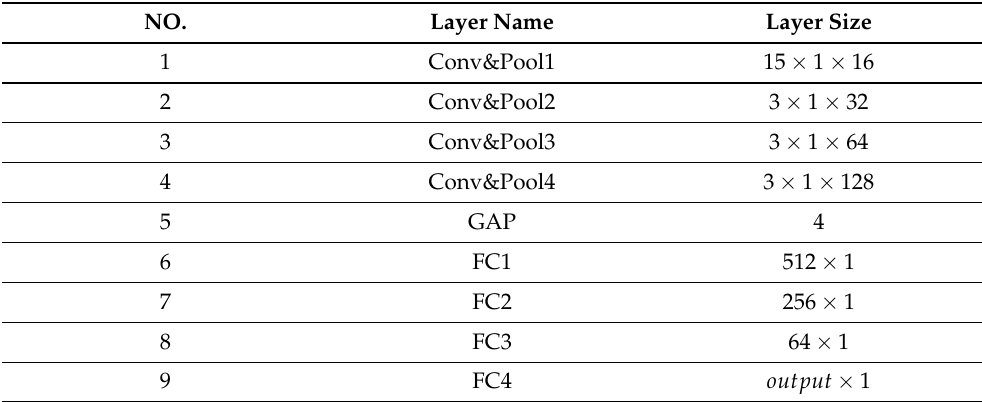
Table 4. Architecture-related hyperparameters of CNN.